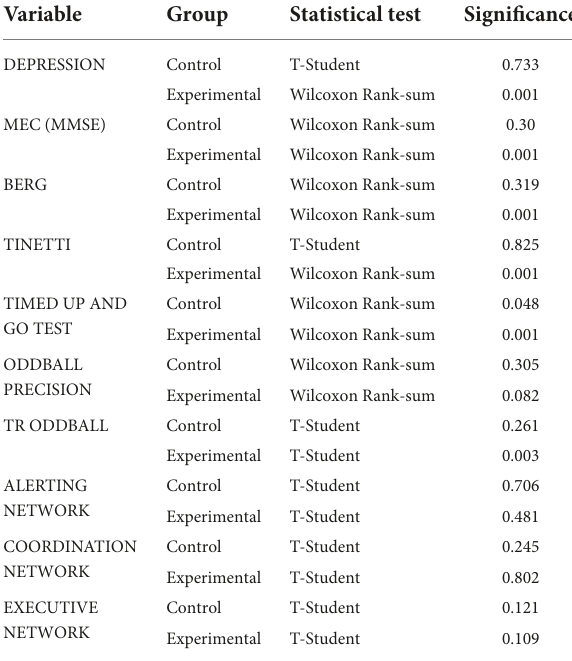
TABLE 2 Descriptives for the difference variables (+ for the median and interquartile range). Own elaboration.